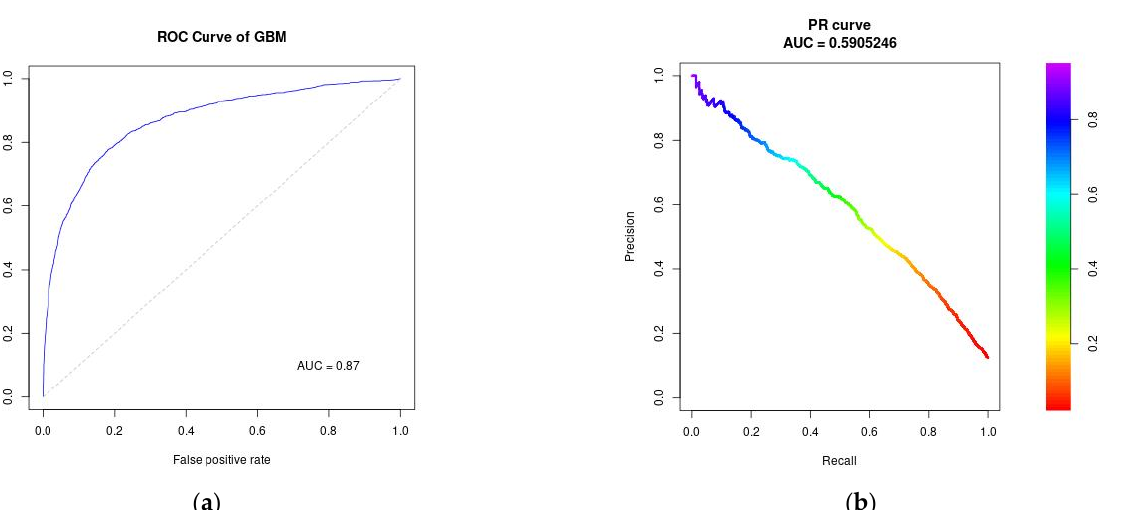
Figure 3. Performance evaluation for Gradient Boosting Machines ( a ) ROC curve; ( b ) Precision-Recall curve.